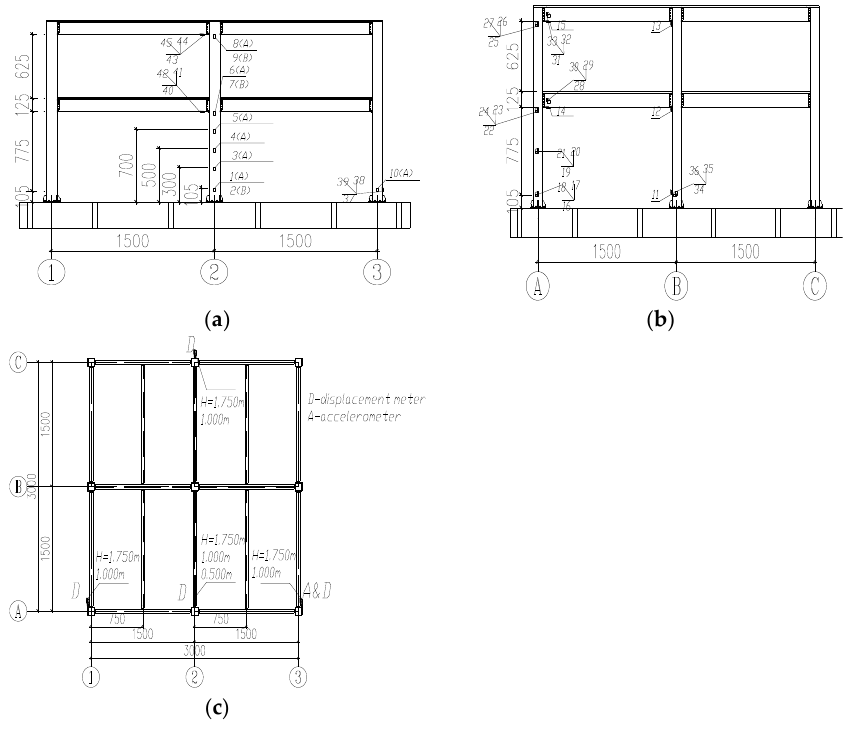
Figure 2. Instrumentation arrangement. ( a ) Strain gauge arrangement of axis A; ( b ) strain gauge arrangement of axis 2; and ( c ) displacement meter and accelerometer arrangement.